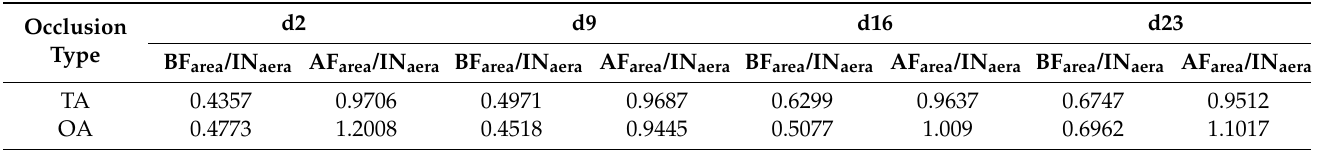
Table 1. The ratio of a broiler chicken area occluded by the equipment before and after restoration compared to an intact broiler chicken area (150 samples